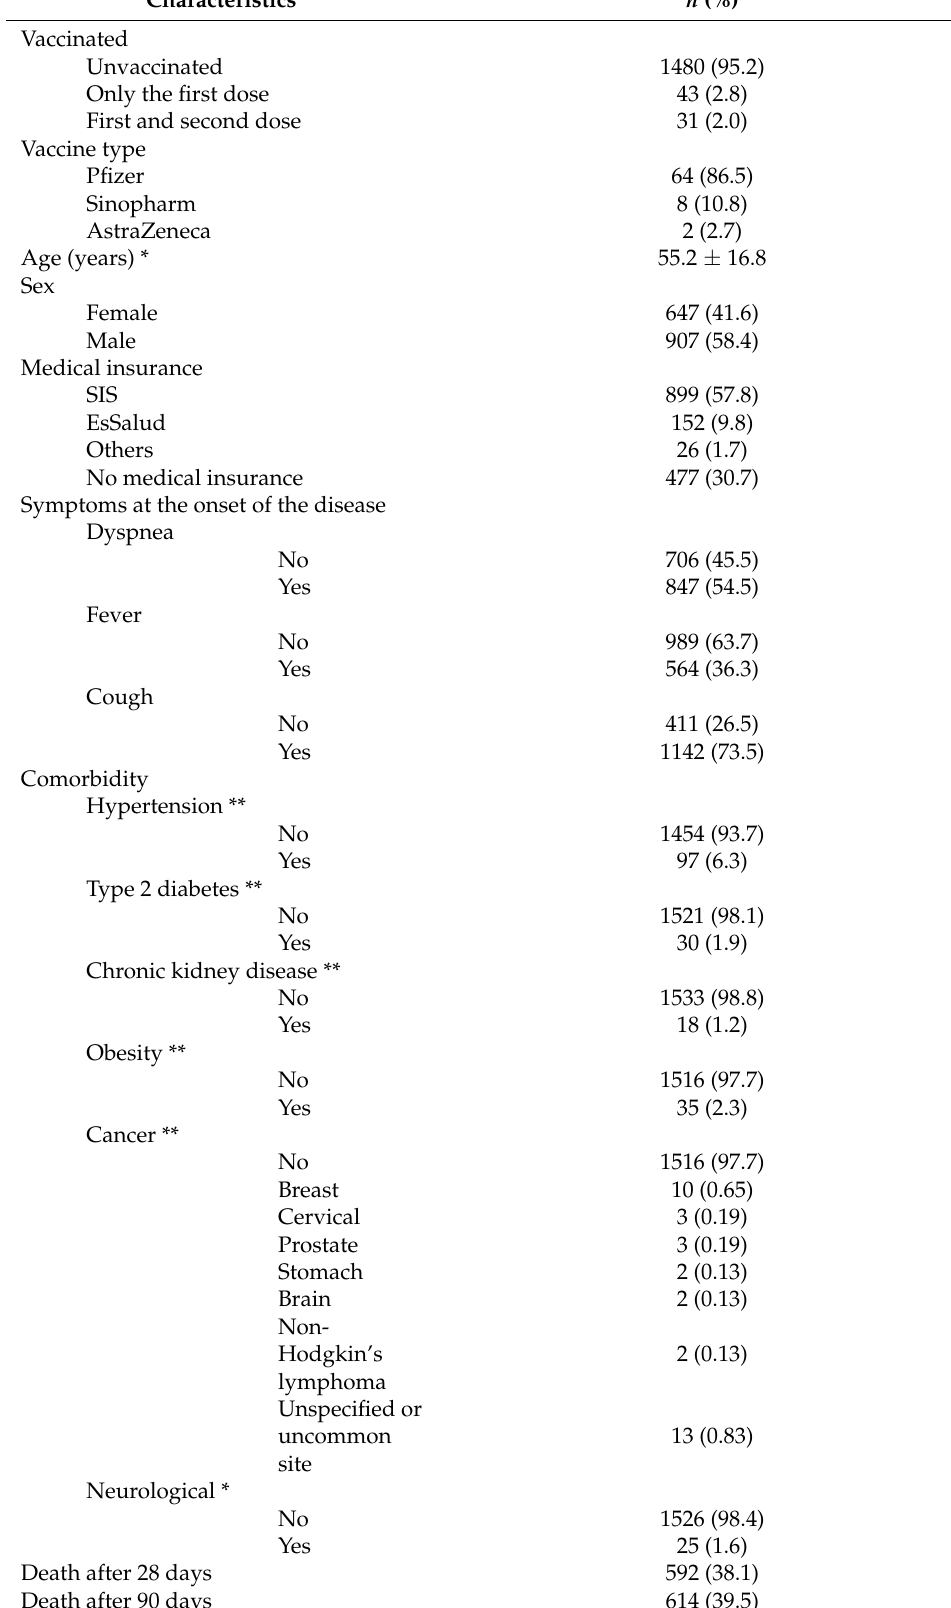
Table 1. Clinical and epidemiological characteristics of hospitalized COVID-19 patients ( n = 1553).